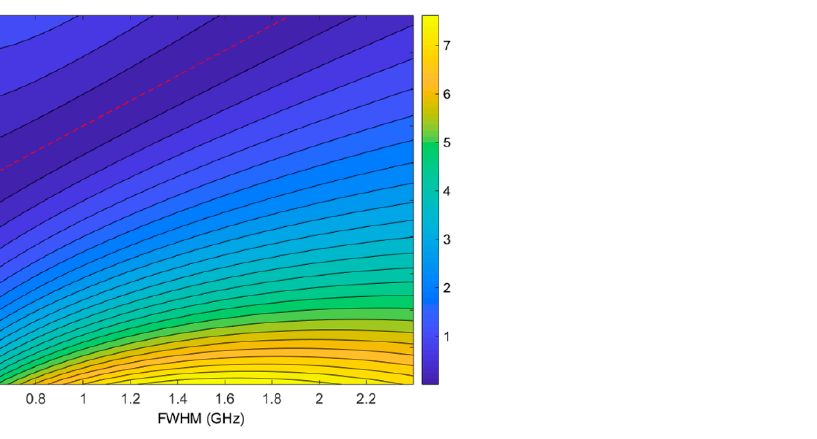
Figure 3. Plot of wind speed error with bandwidth and bimodal spacing as independent variables (considering Rayleigh scattering and Mie scattering).